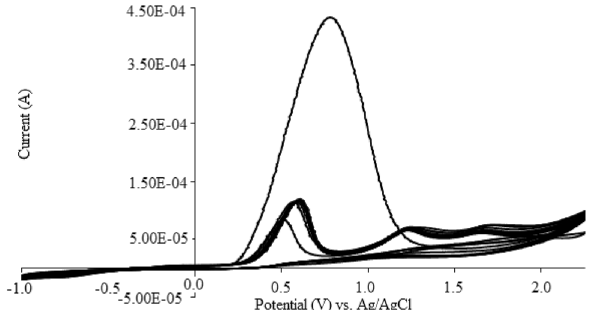
Figure 1. Continuous cyclic voltammograms (CVs) of Salen monomer (0.04 M) in acetone at potential ranging between − 1.0 to + 2.25 V and a scan rate of 100 mV s −1 at pH >